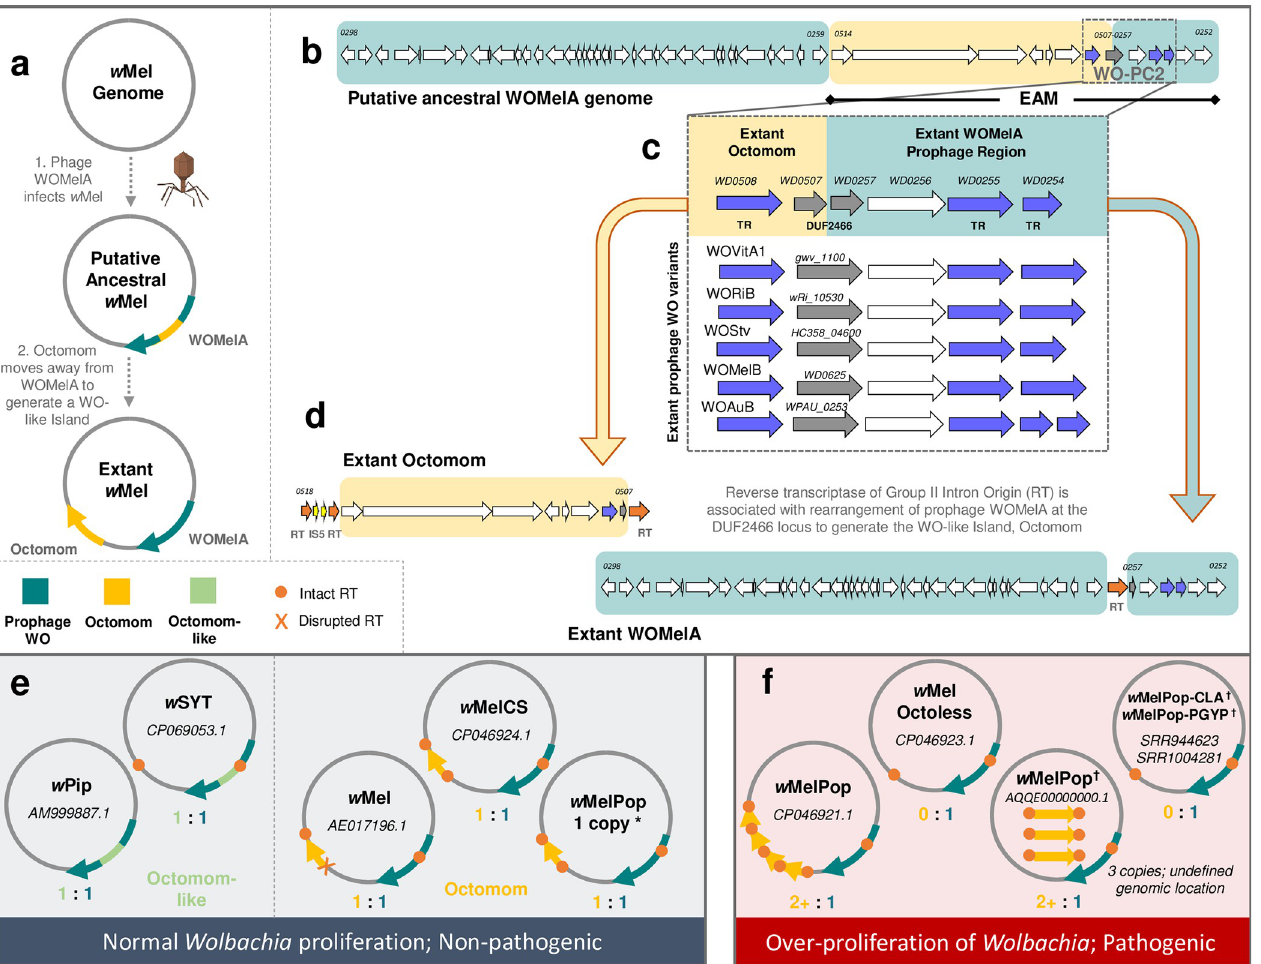
Fig 4. Comparative genomics supports a WO:Octomom origin model for Wolbachia proliferation in wMelPop. (a) A new model for Octomom origin predicts the initial infection of w Mel with a WOMelA phage. After integration, Octomom splits from the WOMelA core prophage region to form a WO-like Island. (b) A genome map of the putative, intact, ancestral WOMelA where Octomom is highlighted in yellow and the extant WOMelA genome in teal illustrates placement of Octomom in the WO EAM. (c-d) An alignment of the WO-PC2 region with closely related prophages shows that half of the conserved module (WD0507-WD0508) is now associated with Octomom and the other half (WD0257-WD0254) remained with WOMelA prophage region. DUF2466 is split across the genomic regions and, when concatenated, shares homology to intact DUF2466 genes of WO-PC2 (see S11 Fig). An IS5 insertion (d) is associated with single-copy Octomom stability in the w Mel chromosome. In wMelCS-like genomes, where the flanking RTs are intact (see S10 Fig), Octomom varies in copy number. (e) When Octomom (orange-yellow) and Octomom-like (green, defined by homology to WD0512, WD0513 and WO-PC2; illustrated in S10 Fig) regions exist in a single copy, either within or outside the corresponding prophage region, Wolbachia proliferation is normal, and it is non- pathogenic. (f) If the WO-like Island occurs in multiple copies or is absent from the genome, Wolbachia over-proliferate and are pathogenic. ( � ) Restoring the 1:1 (WO:Octomom) ratio returns the w MelPop phenotype back to normal levels. The association of Octomom with pathogenicity (i.e., correlation vs. causation) is still to be determined [66–68].NCBI accession numbers are listed for each genome; (†) indicates circular genomes are unavailable and genomic locations are